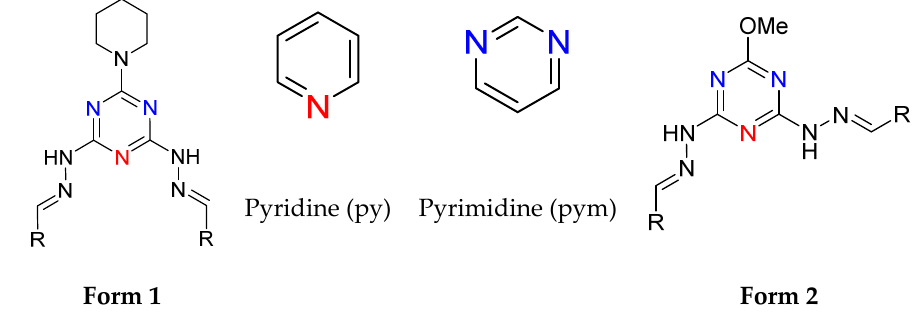
Figure 1. The general structure of s -triazine bis -Schiff base.